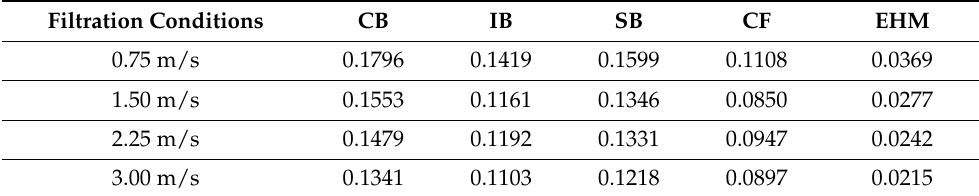
Table 13. RMSE results obtained in Example 4 for different cross-flow